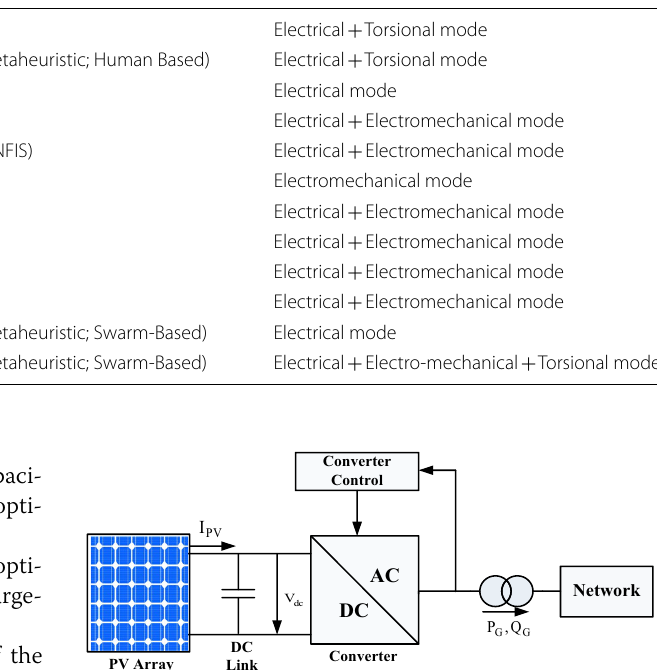
Table 1 This work versus previous studies (a comparative analysis) Previous works